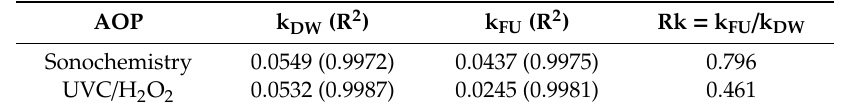
Table 2. Kinetic constants (in min − 1 ) determined in the degradation of losartan in fresh urine (k FU ) and distilled water (k DW ) for each advanced oxidation processes 1